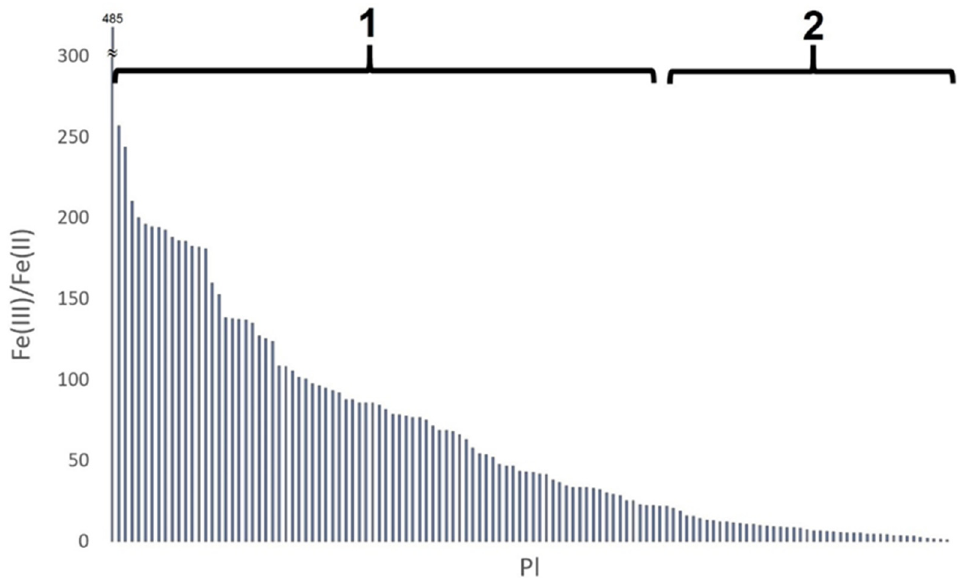
Figure 6. The Fe(III)/Fe(II) ratio for samples from site Pl: 1—the group of samples with Fe(III)/Fe(II) ratio greater than or equal to 20; 2—the group of samples with Fe(III)/Fe(II) ratio less than 20.